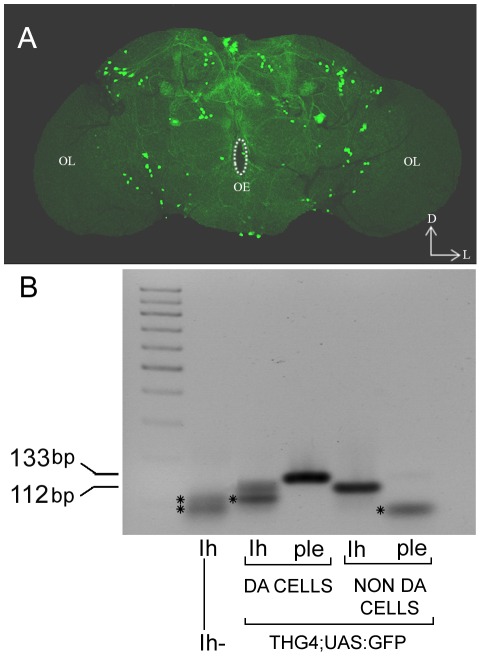

Ih gene is expressed in dopaminergic neurons.(A) Confocal projection of adult brain showing dopaminergic neurons labeled with GFP using the Tyrosine Hydroxilase Gal4 driver (THG4;UAS:GFP). D, dorsal, L, lateral, OE, oesophagus, OL, optic lobe. (B) RT-PCR amplification of Ih (112 bp) and ple (133 bp) RNAs from 200 isolated dopaminergic and non-dopaminergic neurons sorted by Fluorescence Activated Cell Sorting (FACS). Image shows amplification of Ih RNA in dopaminergic, ple-expressing neurons. Failure to PCR-amplify the neuronal ple RNA isoform in non-dopaminergic neurons (GFP negative cells) confirms that cells have been correctly sorted. Asterisks in lanes 1, 2, and 5 point to nonspecific bands, which were obtained in the negative controls (DmIh mutant brain-RNA extract for Ih –lane 1- and GFP-negative cell-RNA extract for ple –lane 5-).